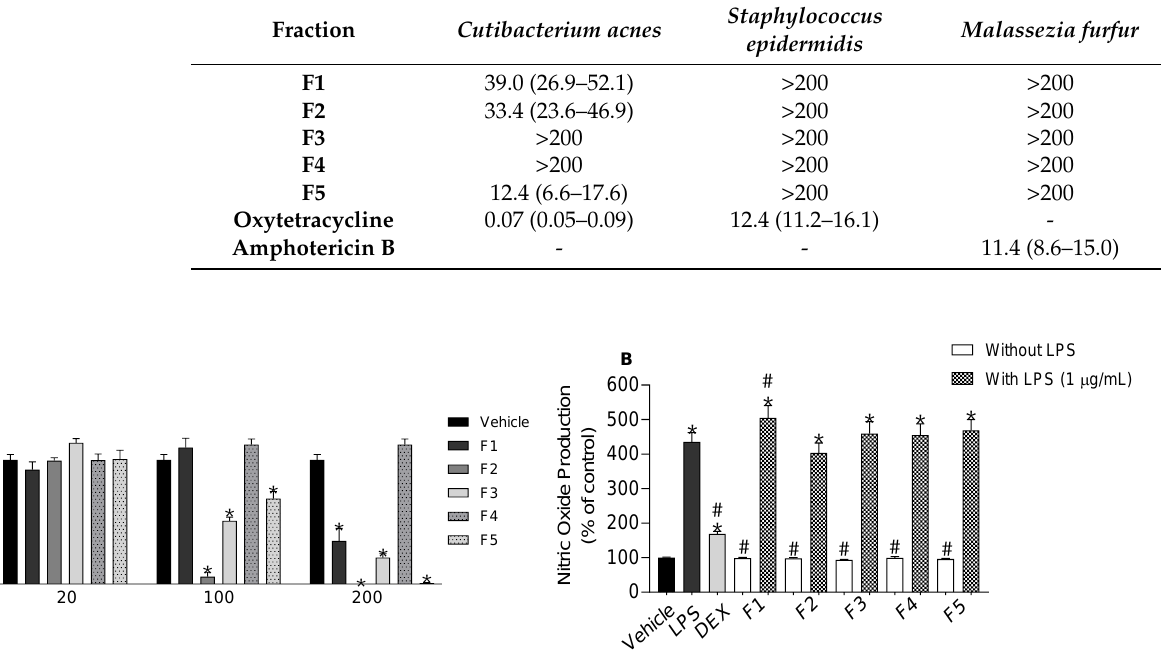
Figure 4. Effect of Saccorhiza polyschides fractions (200 µ g/mL) on the growth of Cutibacterium acnes ( A ) , Staphylococcus epidermidis ( B ) and Malassezia furfur ( C ). Symbol (*) represents significant differences (one-way ANOVA, Dunnett’s test; p < 0.05) when compared to vehicle. Table 2. Antimicrobial activity (IC 50 , µ g/mL) of Saccorhiza polyschides fractions, oxytetracycline and amphotericin B.